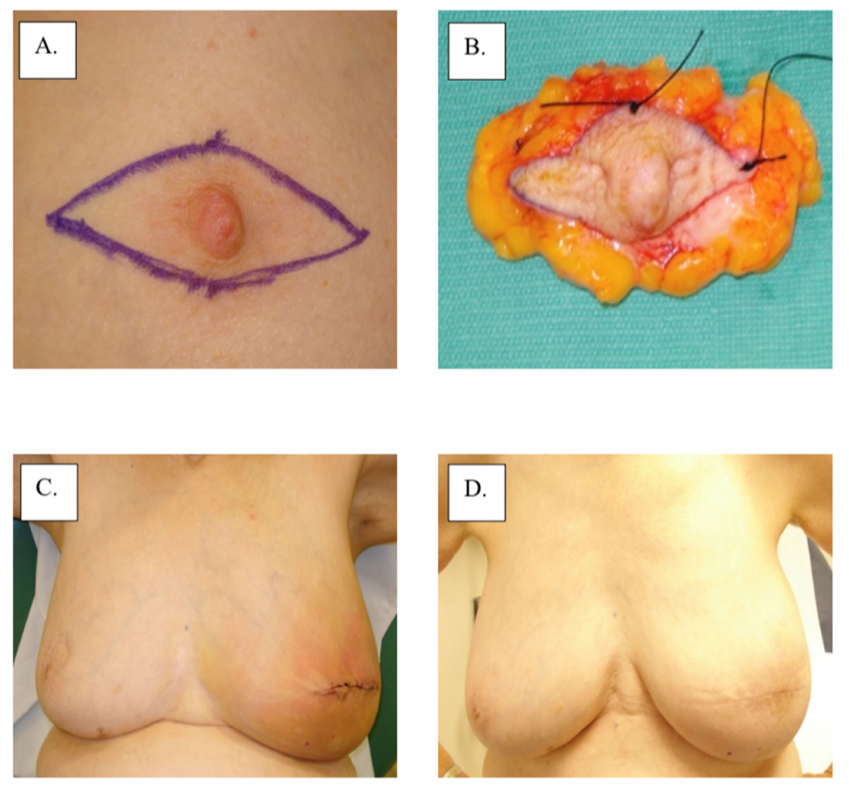
Figure 3. Surgical management with central lumpectomy: ( A ) surgical plan, ( B ) surgical specimen, ( C ) immediate post-operation, and ( D ) 1-year